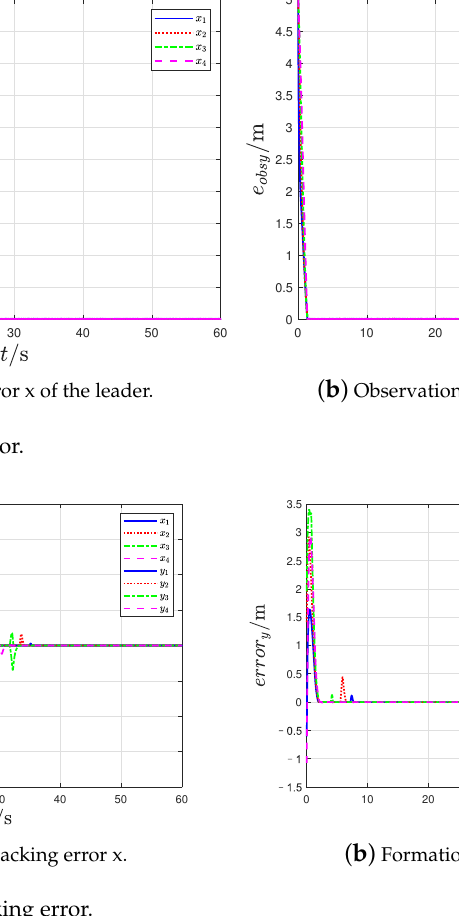
Figure 5. Formation tracking